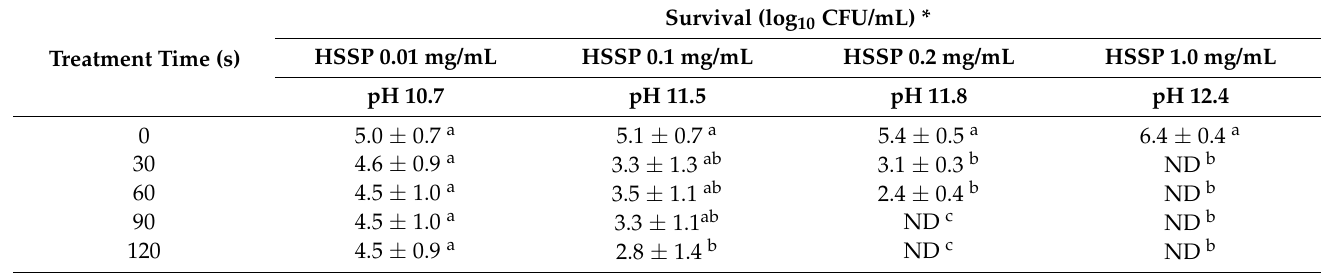
Table 1. Antibacterial effects of heated scallop-shell powder (HSSP) on Campylobacter jejuni ATCC 29428 in planktonic